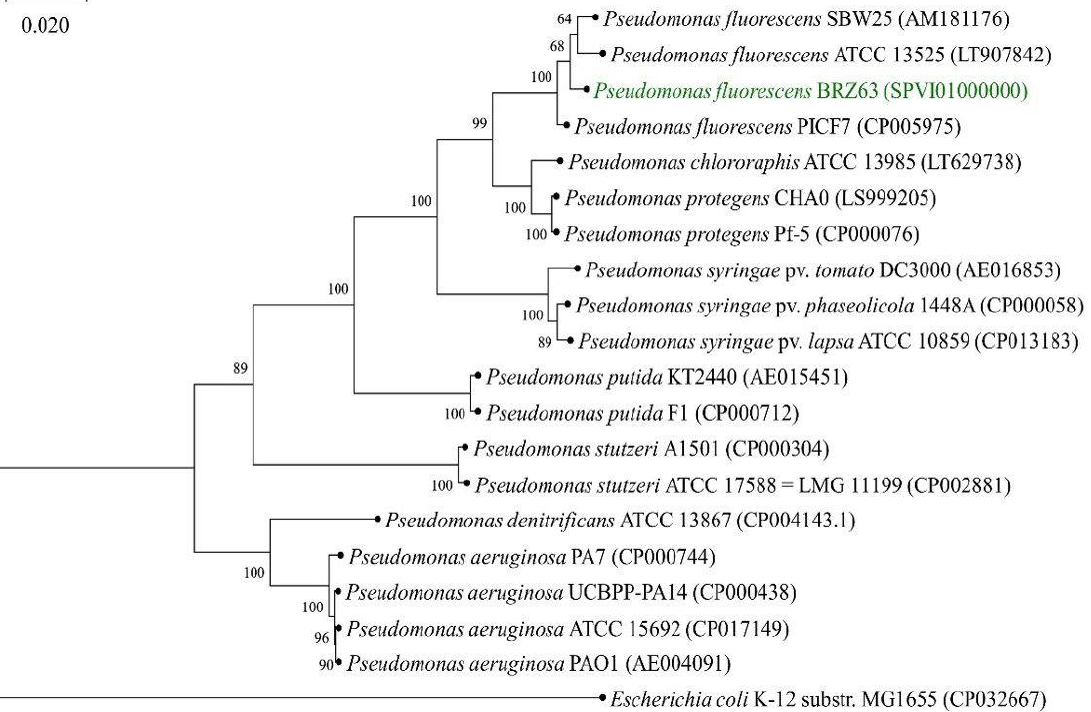
Figure 6. Phylogenetic tree of Pseudomonas fluorescens BRZ63 (marked in green) based on alignment of the core proteome of 20 strains with Escherichia coli K-12 substr. MG1655 as an outgroup. Branching percentage values were determined with the use of the 1000 bootstraps resampling test. The accession numbers for genomes are shown in brackets. The tree was constructed using the maximum likelihood method. The scale bar represents 1% nucleotide sequence divergence.